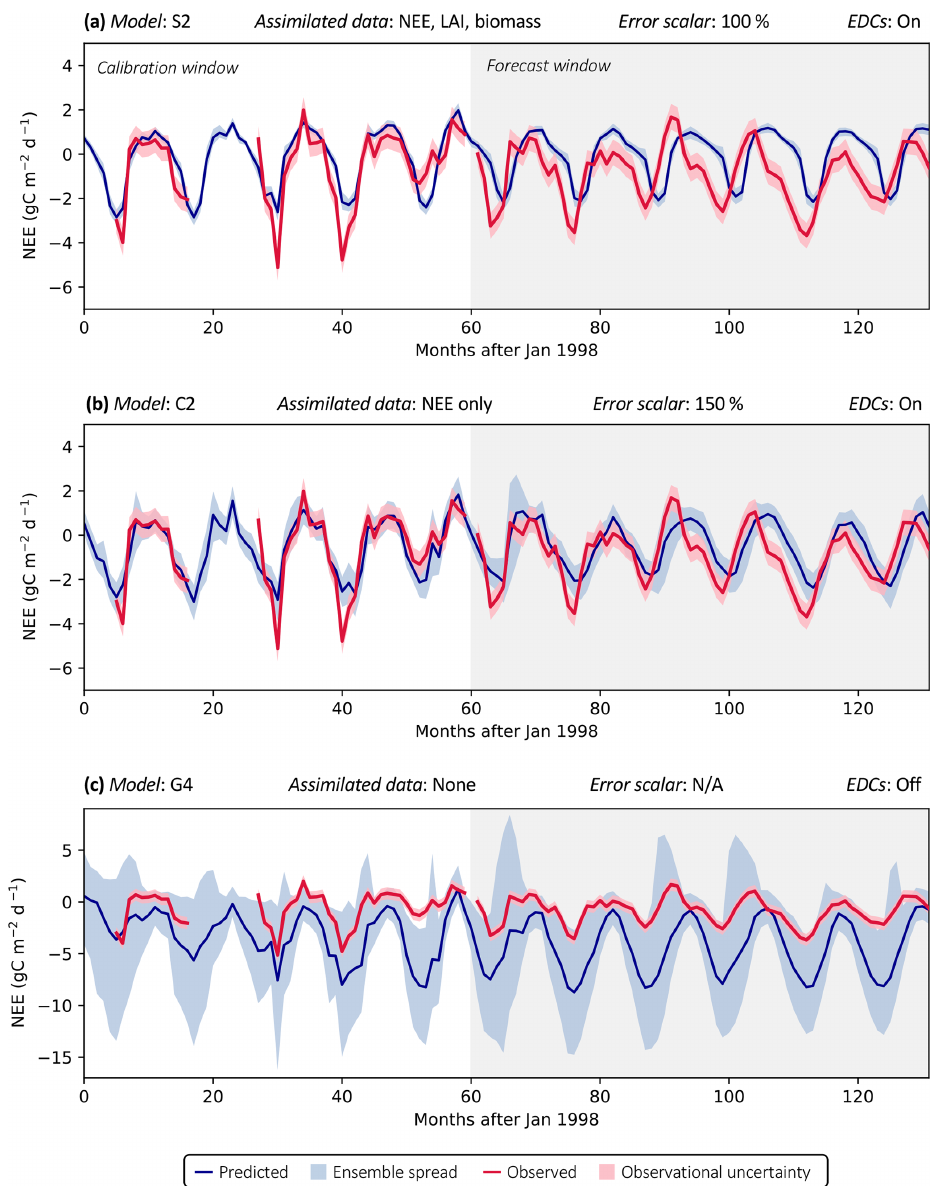
Figure 3. Example model runs (title of each subplot) at the FR-LBr site. The calibration window – the first 5 years of the record – is shown in white, and the forecast window is shaded gray. The ensemble spread (blue shading) encapsulates the 5th–95th percentiles of runs. (a) Forecast skill = 0.15; effective complexity = 7; (b) forecast skill = 0.44; effective complexity = 24; (c) forecast skill = 0.22; effective complexity =